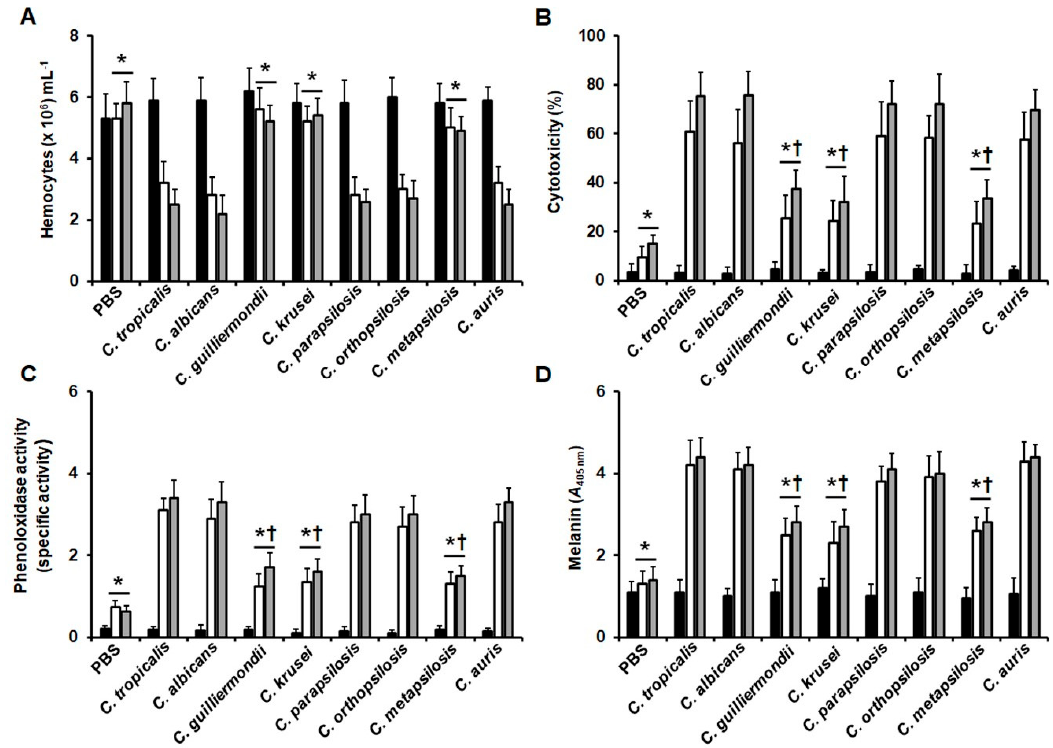
Figure 6. Quantification of hemocytes, melanin, phenoloxidase activity, and cytotoxicity in Galleria mellonella larvae infected with different Candida species. Groups of 10 animals were infected with 2 × 10 7 yeast cells from the different species under study, incubated for the indicated time at 37 °C, animals were decapitated, hemolymph collected and used to quantify the hemocytes concentration ( A ), cytotoxicity ( B ), phenoloxidase activity ( C ), or melanin production ( D ). In B, cytotoxicity was measured as the lactate dehydrogenase activity in the cell-free hemolymph and the 100% cytotoxicity corresponds to the enzyme activity quantified from lysed hemocytes. In C, the specific activity was defined as the change in the absorbance at 490 nm per one minute per one µg protein. Closed, open, and grey bars correspond to measurements at 0 h, 12 h, and 24 h postinoculation, respectively. Data are plotted as means ± standard deviation of three independent experiments performed by duplicated. * p < 0.05 when compared to the values gathered at the same postinoculation time in animals infected with C. tropicalis . † p < 0.05 when compared to the control condition at the same postinoculation time.